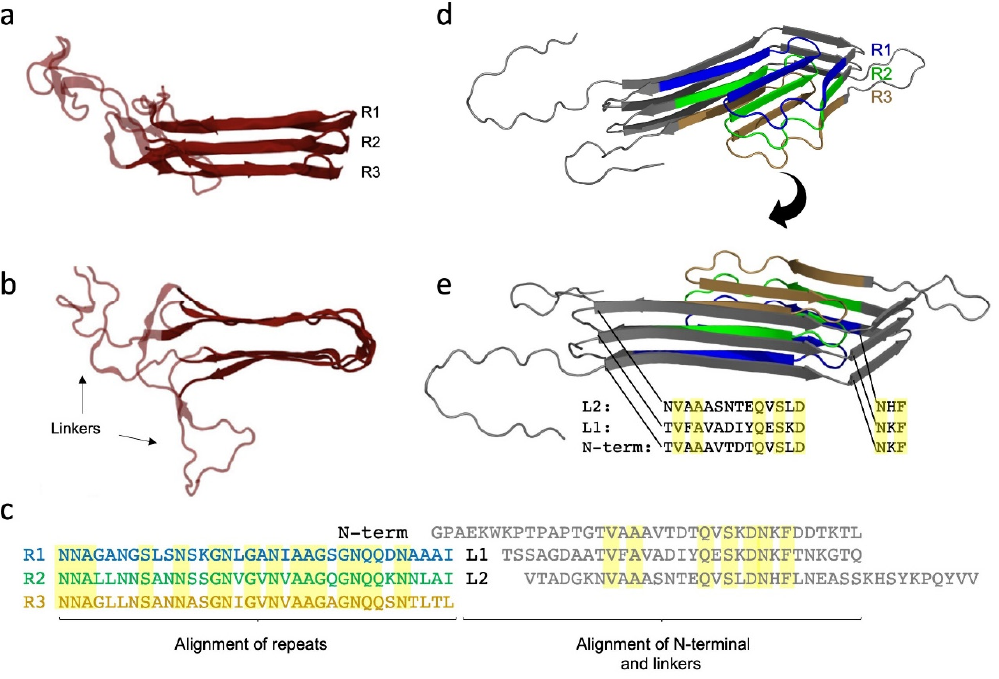
Figure 4. ( a ) FapC is predicted to form a β -helix where the three imperfect repeats R1–R3 stack on top of each other. ( b ) Top-view of the predicted β -helix of FapC. FapC’s long linkers (31 and 39 residue lengths) are marked. Panels a and b modified from [38]. ( c ) Alignment of the primary sequence of the repeats R1, R2 and R3 and the N-terminal and linkers, L1 and L2. “Ladders” formed from different kinds of conserved residues are highlighted. ( d , e ) Predicted FapC structure from AlphaFold seen at two different angles. The repeat sequences are colored blue (R1), green (R2), orange (R3).